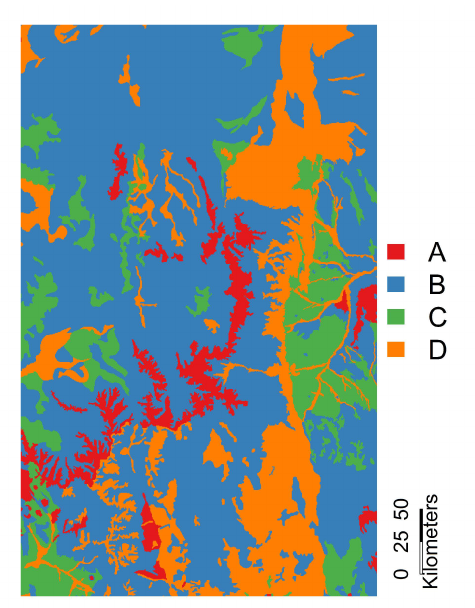
Figure A6. Hydrologic soil groups for the region of interest where A represents the highest transmissivities and infiltration rates, and these decrease in groups B and C, reaching highly impervious soils in group